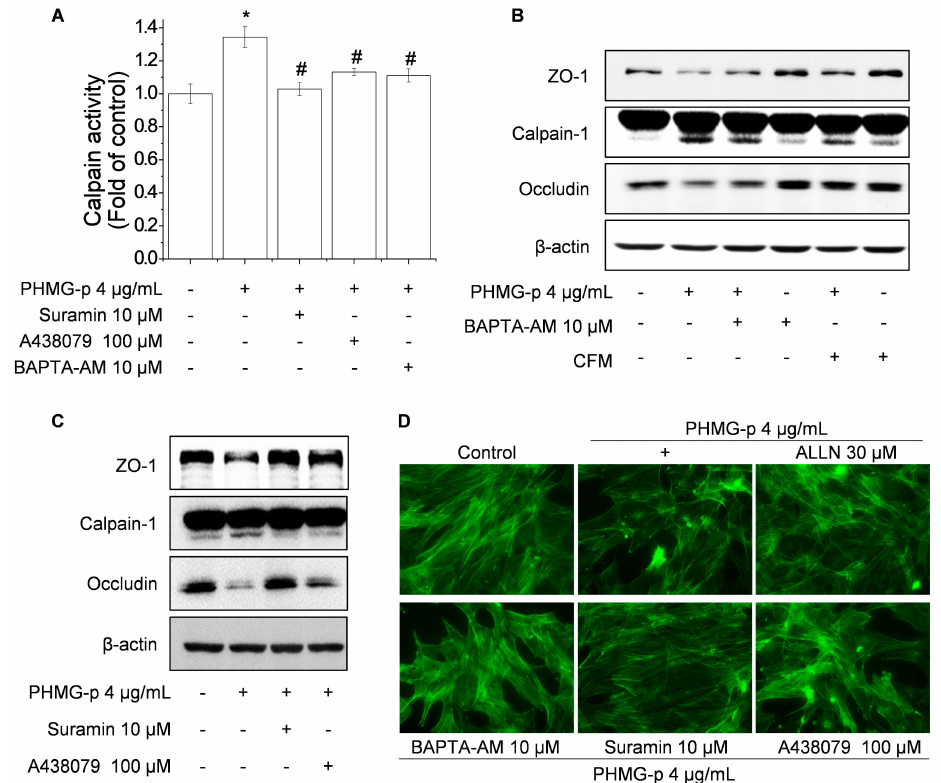
Figure 4. Blockade of PHMG-p-mediated intracellular Ca 2 + influx reduces calpain-1 activity and calpain-1-dependent disruption of the epithelial barrier. ( A ) Cells were treated with or without 10 µ M suramin, 100 µ M A438079, and 10 µ M BAPTA-AM, followed by incubation with 4 µ g / mL PHMG-p, then subjected to calpain activity assay. ( B , C ) Cells were treated with 10 µ M BAPTA-AM, 10 µ M suramin, and 100 µ M A438079, or medium was replaced with Ca 2 + -free DMEM / F-12 (CFM), followed by incubation with 4 µ g / mL PHMG-p and western blotting. ( D ) Cells were treated with or without 10 µ M suramin, 100 µ M A438079, 10 µ M BAPTA-AM, and 30 µ M ALLN, followed by incubation with 4 µ g / mL PHMG-p and F-actin staining. * p < 0.01, significantly di ff erent from the control. # p <